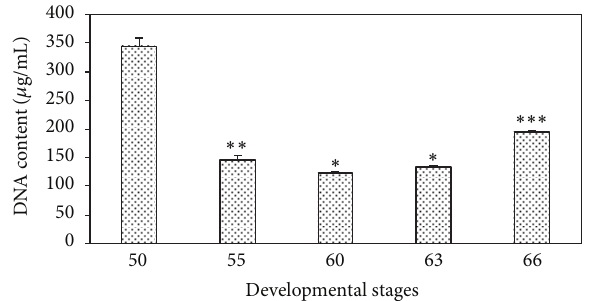
Figure 6: Changes in the DNA content before, during, and after metamorphosis in the developing small intestine of the toad Bufo regularis . Data are represented as mean ± SEM ( 𝑛 = 6 ). ∗∗∗ 𝑃 < 0.0001, ∗∗ 𝑃 < 0.001, and ∗ 𝑃 < 0.05 .